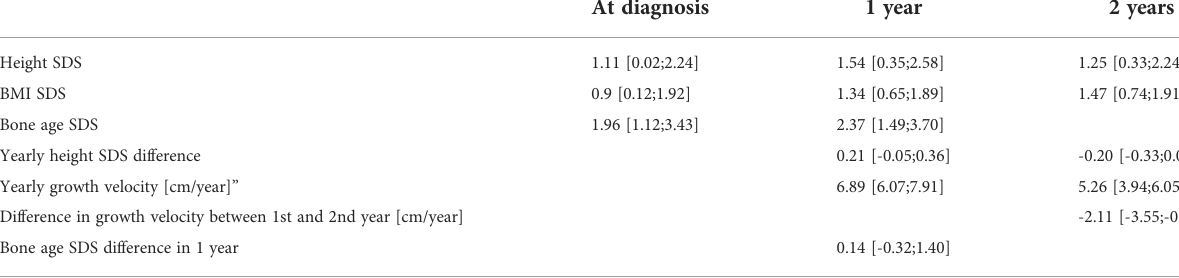
TABLE 5 Evaluation of anthropometric changes and bone age 1 year and 2 years after